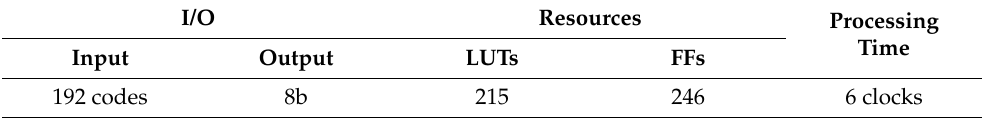
Figure 3. Combinatory encoder of ones and zeros counters. Table 1. Summary of the ones and zeros combinatory counters